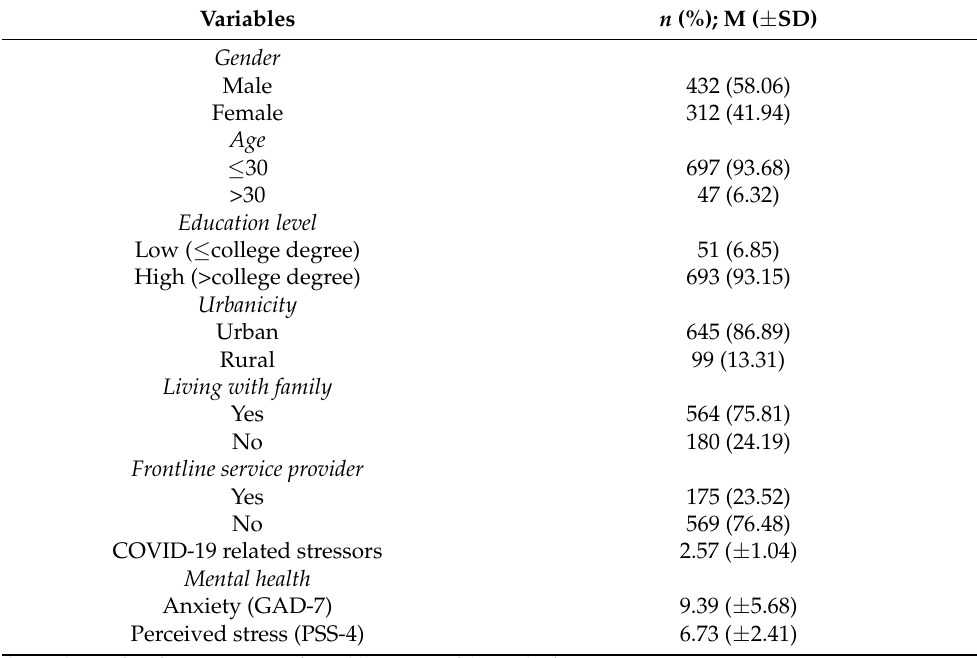
Table 1. Descriptive statistics, COVID-19 related stressors, and mental health of respondents ( n = 744).